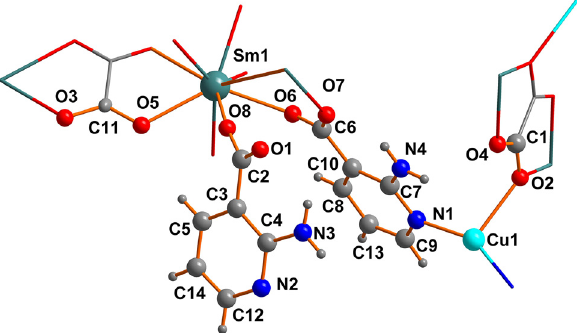
Table  : Data collection and